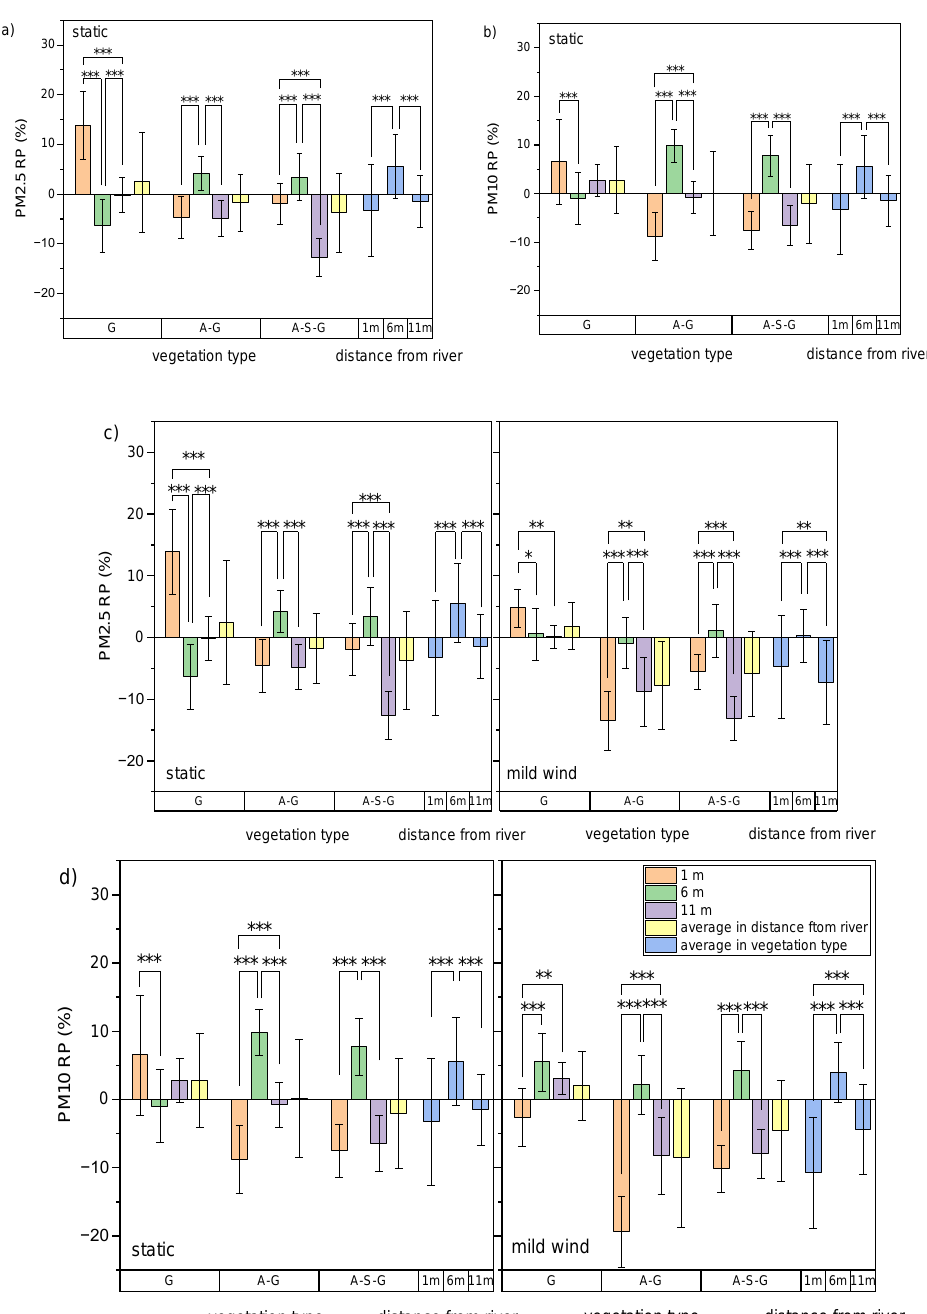
Figure 6. ANOVA results of ( a ) the PM 2.5 removal percentage and ( b ) the PM 10 removal percentage during the entire observation period; ANOVA results of ( c ) the PM 2.5 removal percentage and ( d ) the PM 10 removal percentage during mild-wind and static periods, respectively. * p ≤ 0.05 ** p ≤ 0.01 *** p ≤ 0.001. Error bar: standard deviation; G: open grassland; AG: arbor-grass woodland; ASG: arbor-shrub-grass woodland.